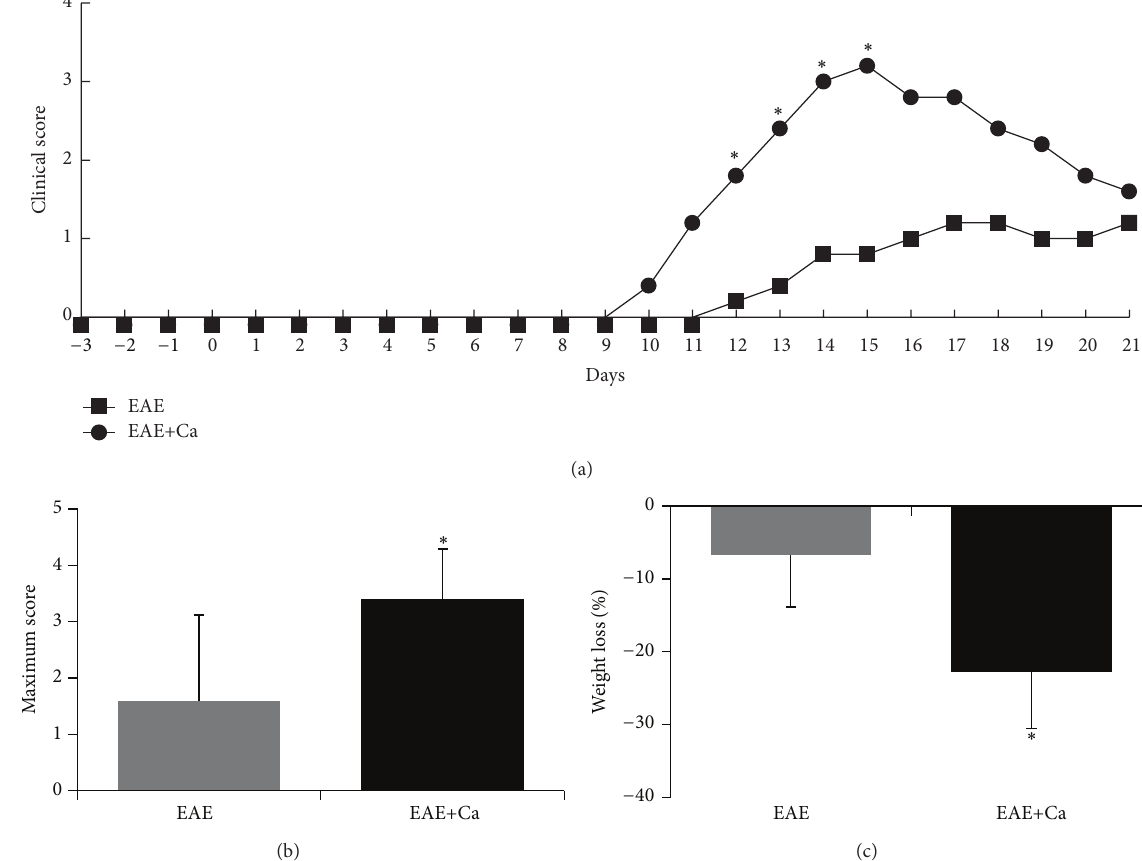
Figure 3: Effect of C. albicans on EAE development. C57BL/6 mice were infected with C. albicans 3 days before EAE induction. Disease development was followed during 21 days. Clinical scores (a) were checked every day and are expressed as mean; maximum clinical score (b) and % of body weight loss (c) were calculated as described in Methods section. The results (a and b) are expressed as mean ± SD ( 𝑛 = 6 – 8 mice/group). Unpaired 𝑡 test, ∗ 𝑃 < 0.05 indicates difference between EAE and EAE+Ca